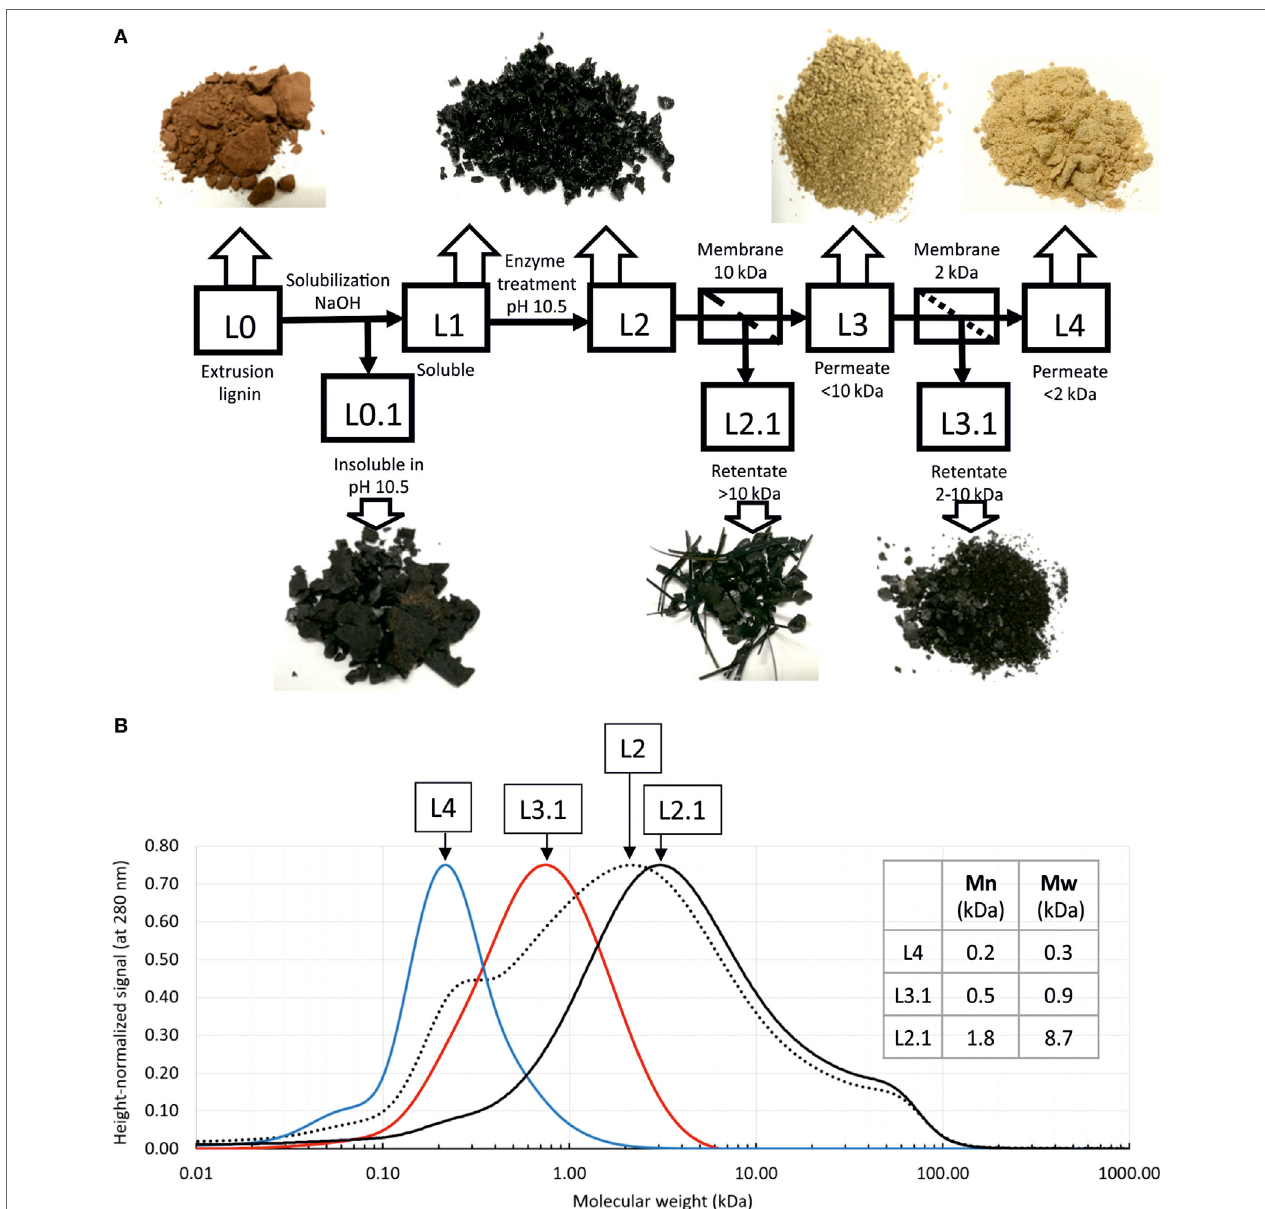
FigUre 5 | Fractionation of enzyme-treated lignin. (a) Experiment flow chart and lignin fractions (dried); (B) analysis of lignin fractions by size exclusion chromatography. Calculated average molecular weights are given in the table. Since claimed column resolution range is 100–100,000 Da, and molecular weight standards range starts from 600 Da, smaller molecular weights may not be calculated